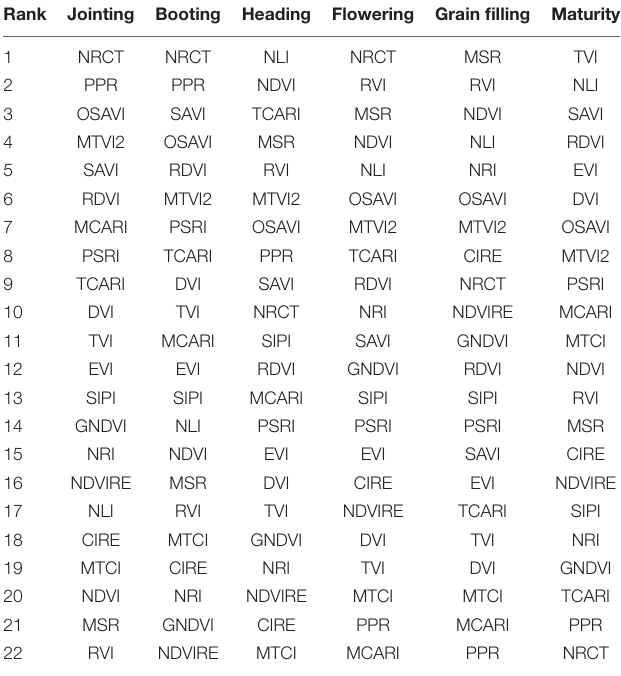
TABLE 5 | Ranking of indices using the gray relational analysis (GRA) for six growth